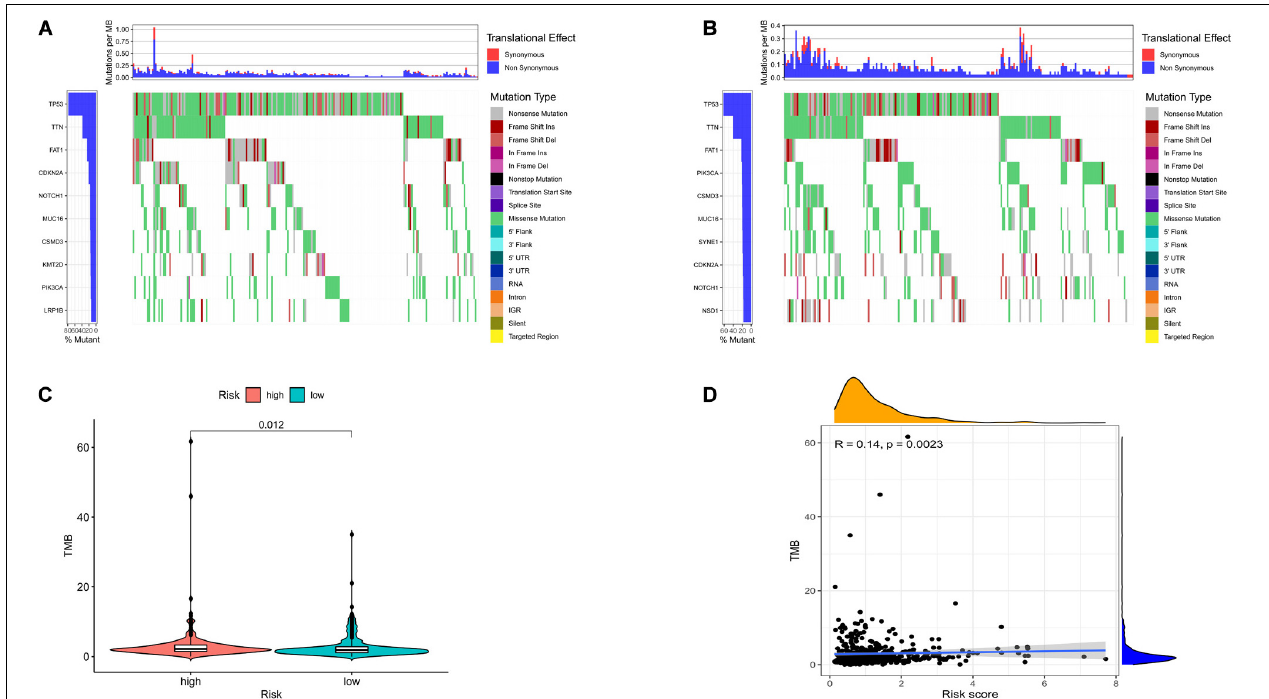
FIGURE 5 | The differences of tumor mutational burden (TMB) in high- and low-risk HNSCC patients. (A) The TMB in high-risk HNSCC patients. (B) The TMB in low-risk HNSCC patients. (C) The difference of TMB was significant in HNSCC patients with different risk. (D) The TMB was positively correlated with the risk score in HNSCC